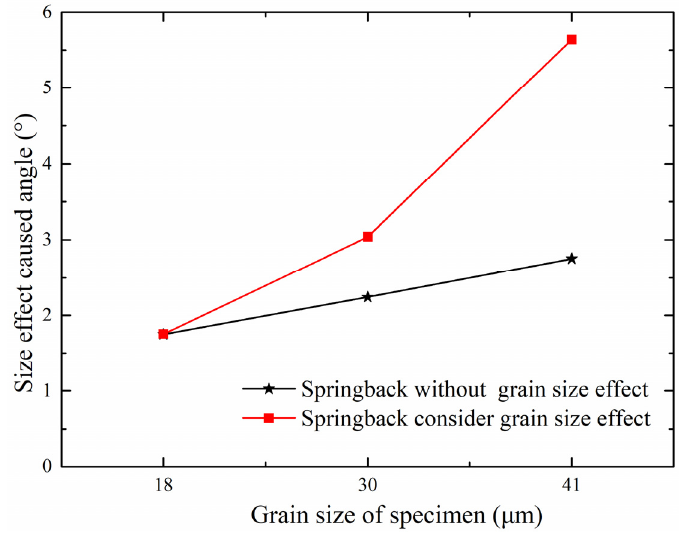
Figure 13. The contribution of strain gradient to springback in sheet metal samples with different grain sizes.